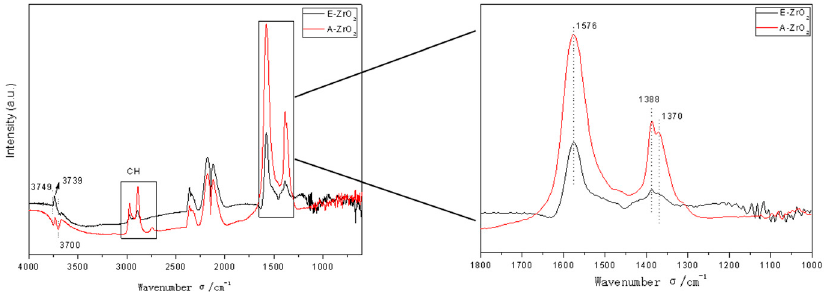
Figure 5. Infrared spectra of E, A-ZrO 2 catalysts exposed to CO.